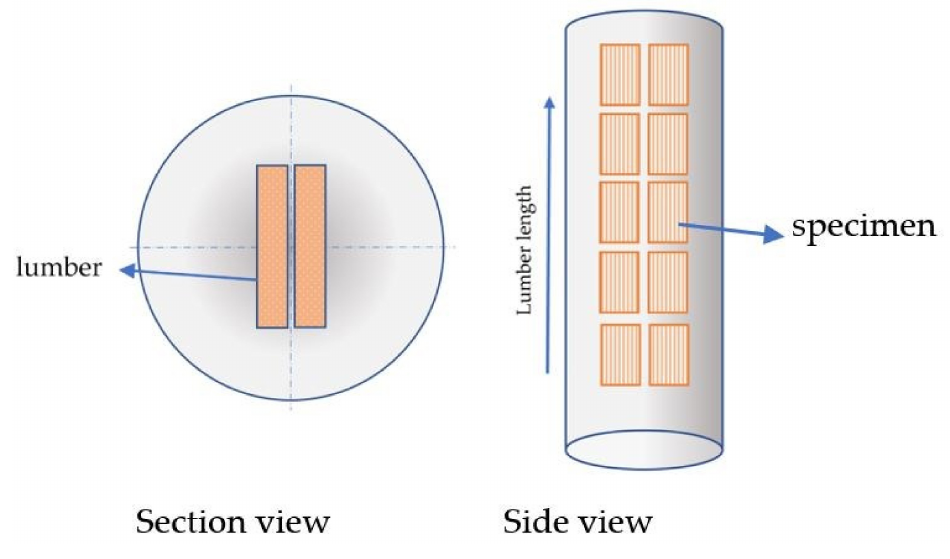
Figure 1. Specimen production scheme.